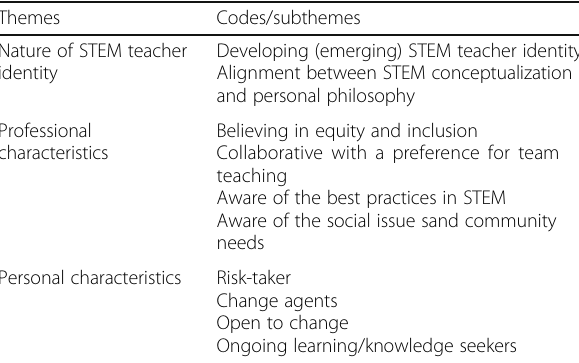
Table 2 Themes and codes/subthemes identified in